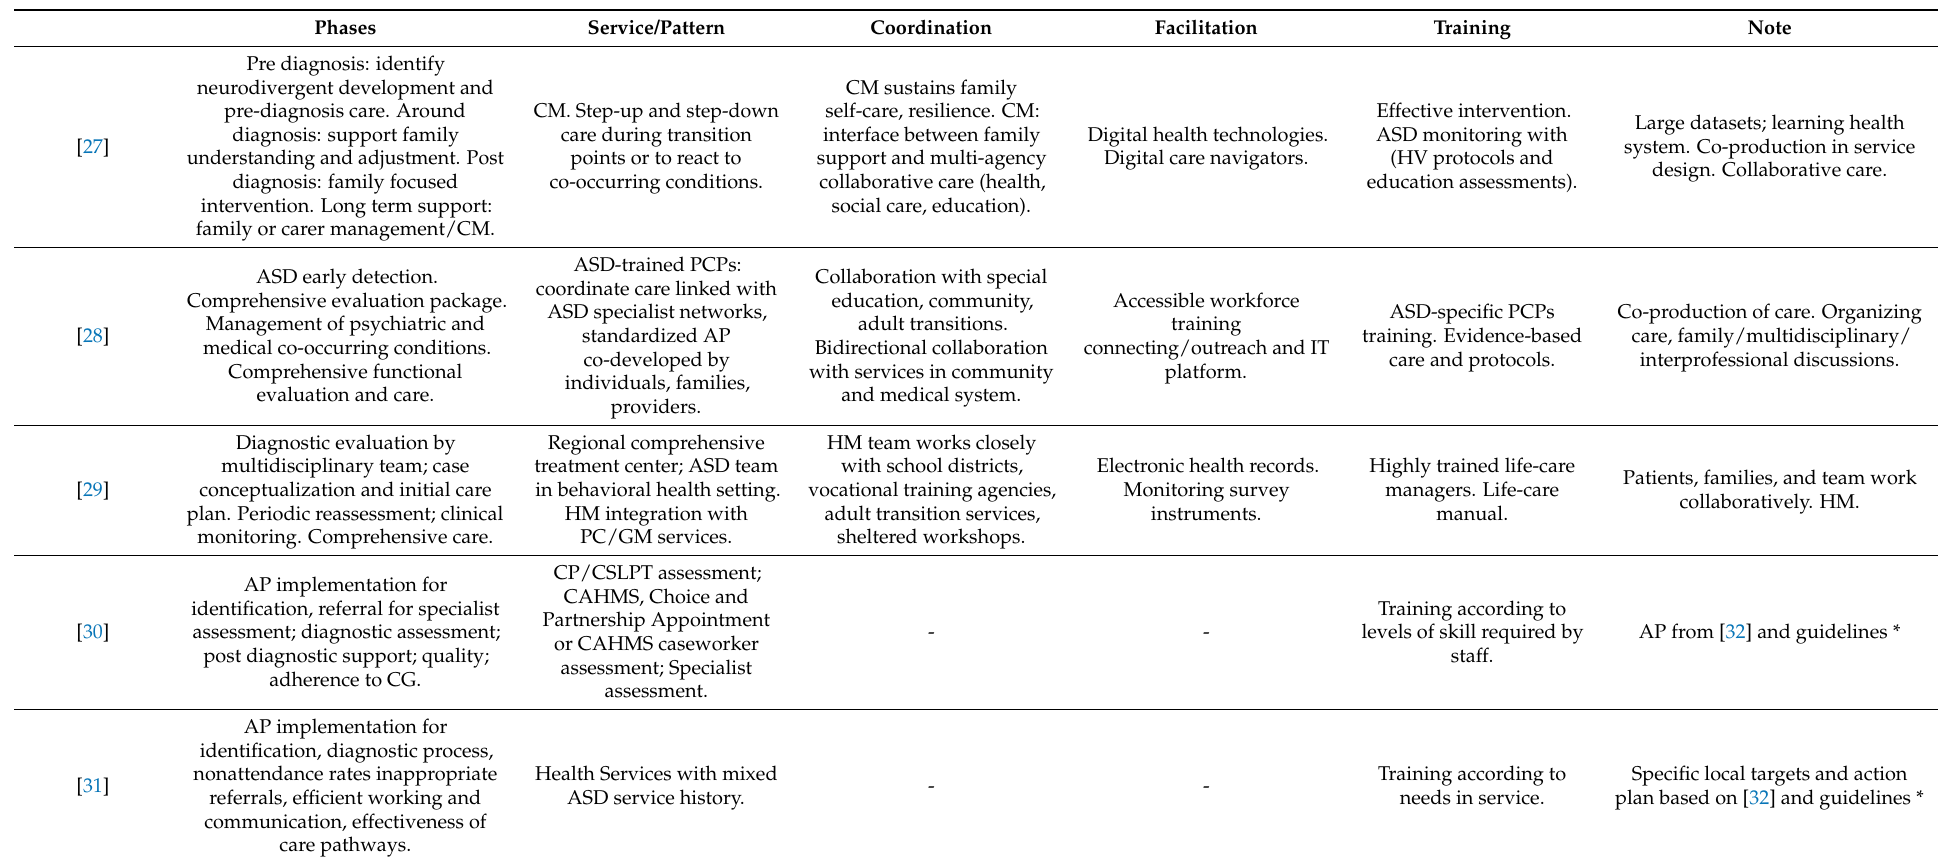
Table 3. Pathway of care of included